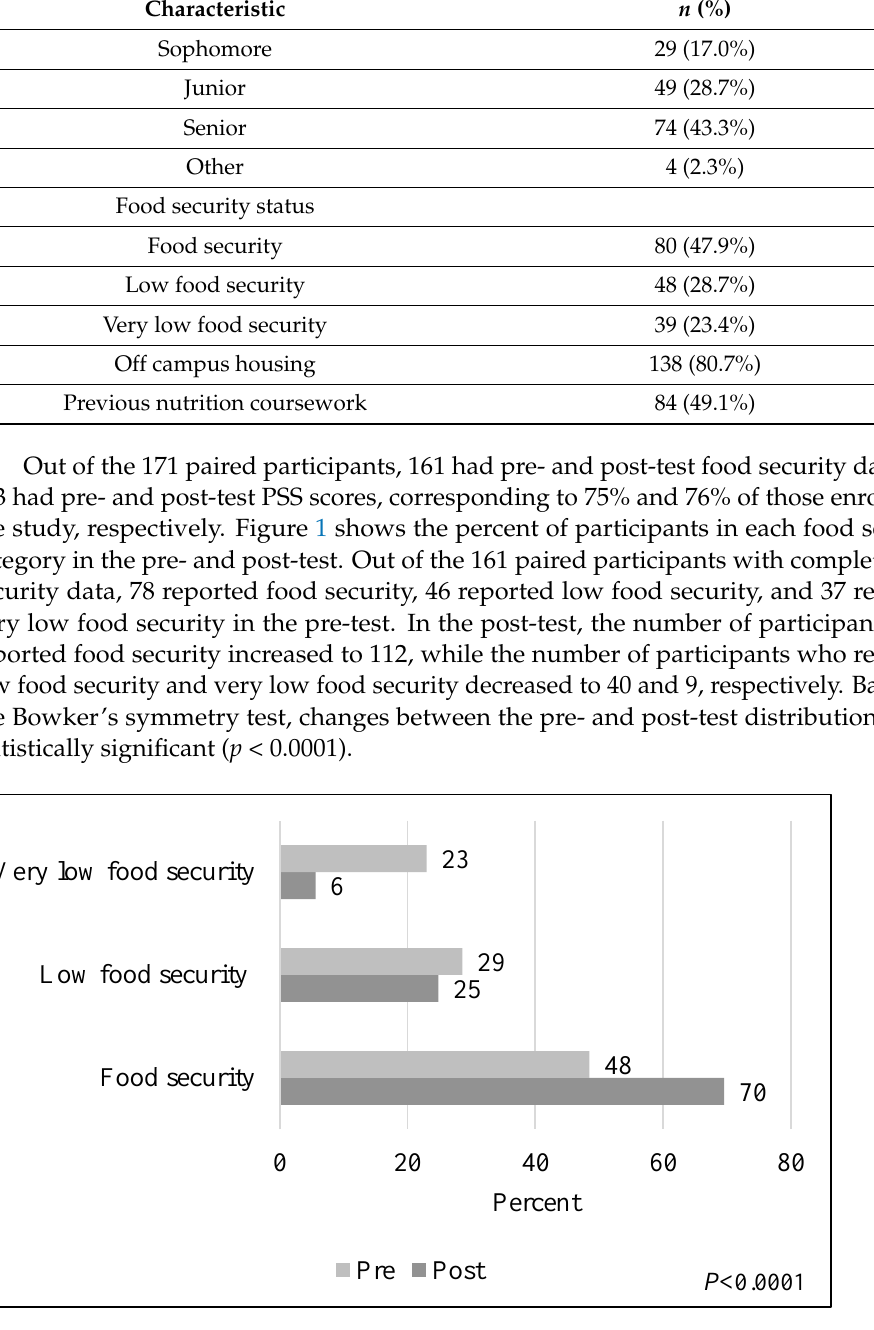
Figure 1. Distribution of food security categories in the pre- and post-test ( n = 161). Among those with complete PSS data, the mean ± SD PSS score was 19.7 ± 5.9 in the pre-test and 18.1 ± 6.0 in the post-test. The mean ∆ (post-pre) score was − 1.6, with a 95% confidence interval ( −2 .3, −0 .8) that did not include zero ( p = 0 .0001), and the Cohen’s effect size for the perceived stress outcome was −0 .27.